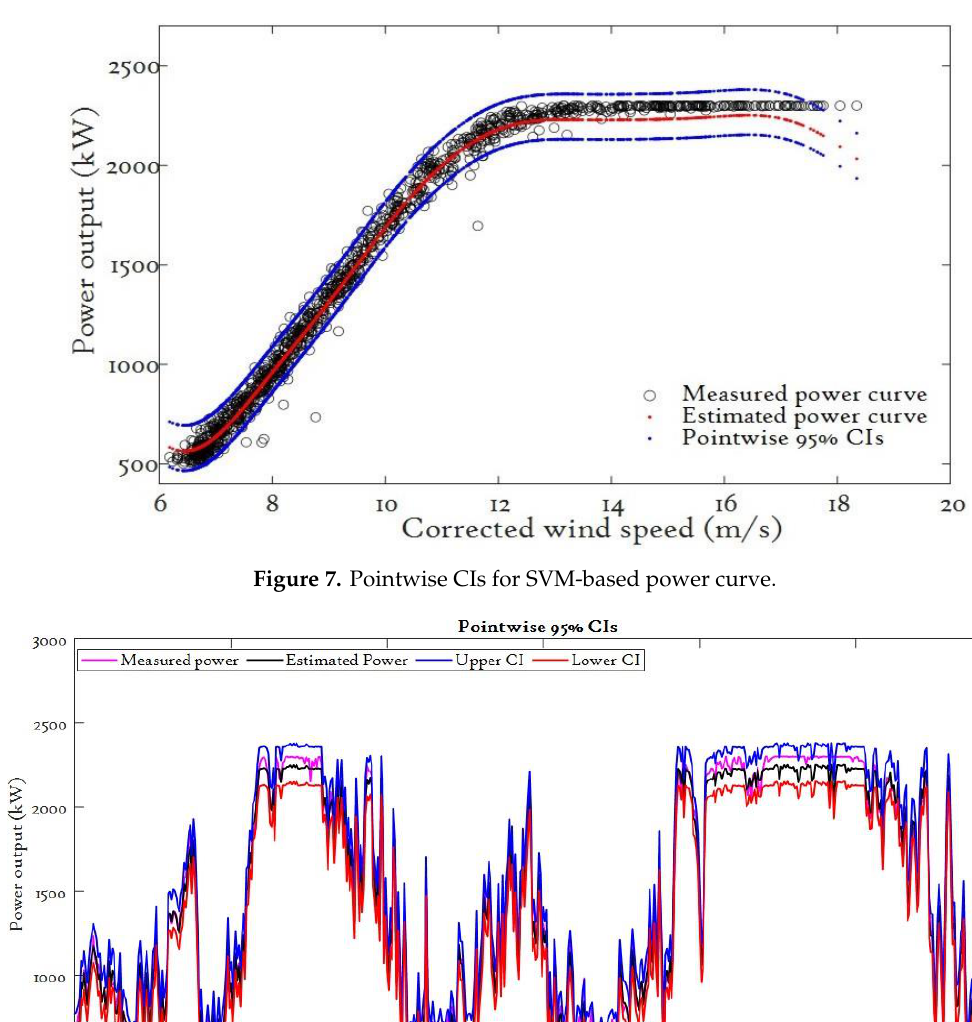
Figure 9. Simultaneous CIs for SVM-based power curve.